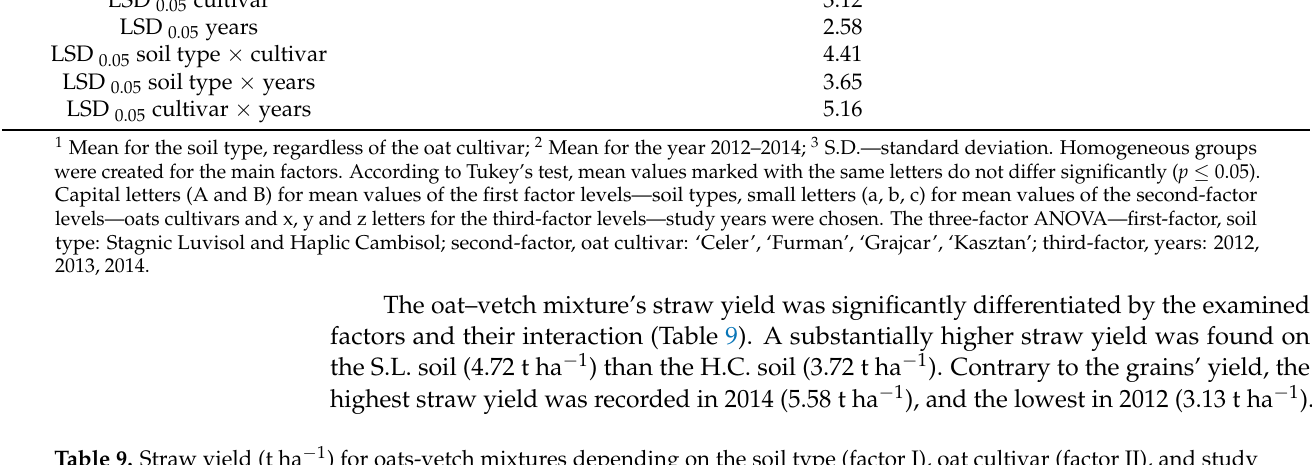
Table 9. Straw yield (t ha − 1 ) for oats-vetch mixtures depending on the soil type (factor I), oat cultivar (factor II), and study years (factor